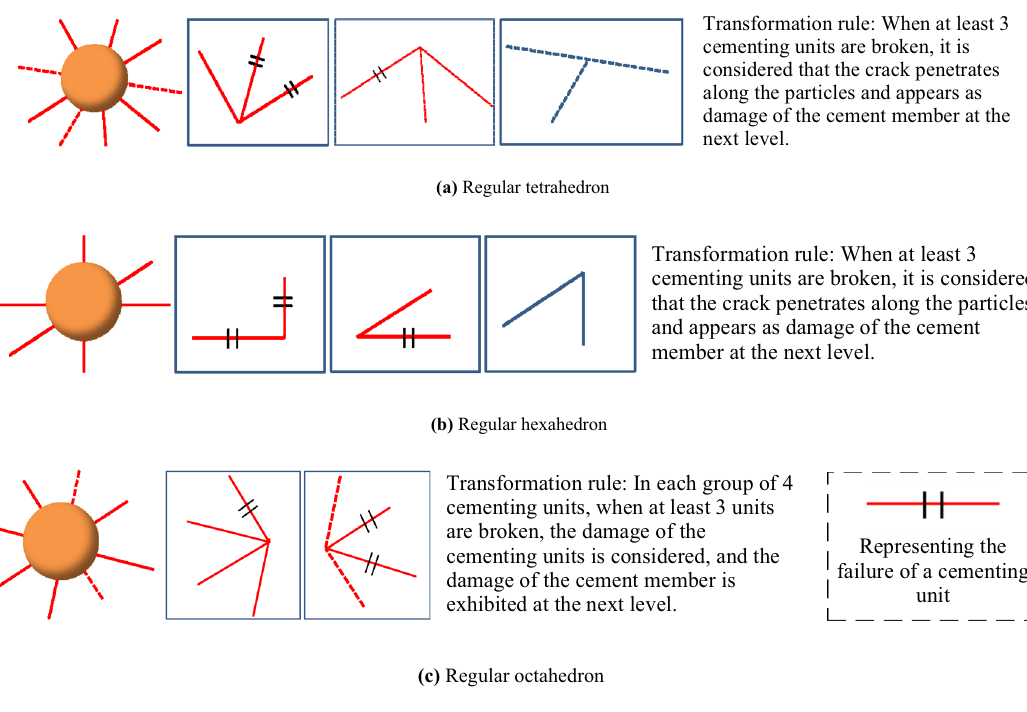
Fig. 5 Renormalization group models of the weakly cemented sandstone: a regular tetrahedron, b regular hexahedron, c regular octahedron